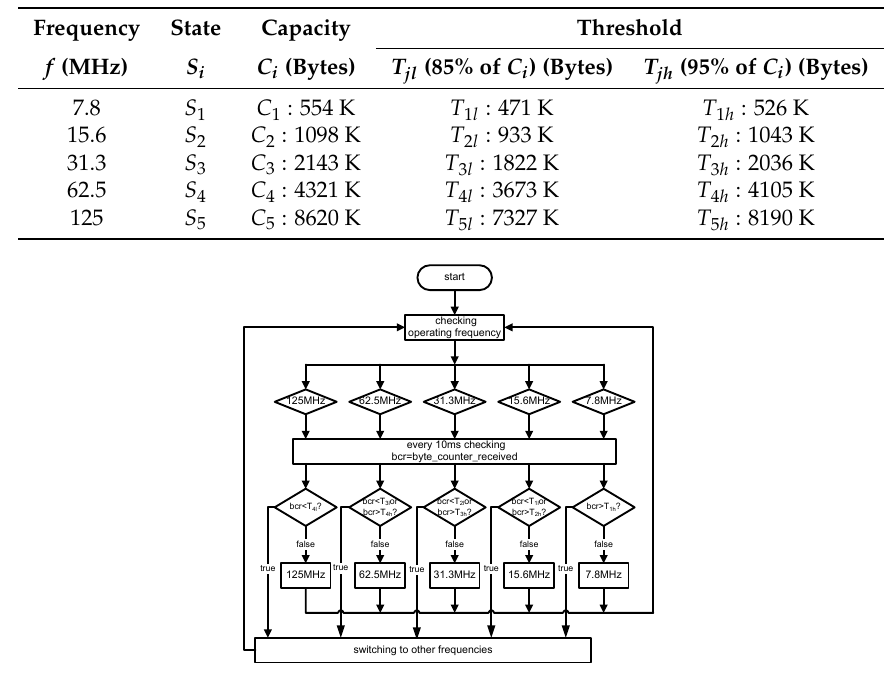
Figure 7. Flowchart of the double-threshold